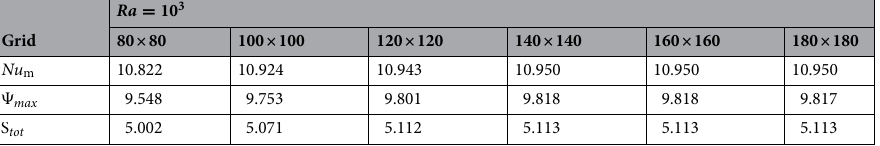
Table 4. The averaged Nusselt number along the cold surface, the maximum stream function and the total entropy for Ha = 20, φ = 0.03, Ra = 10 5 .